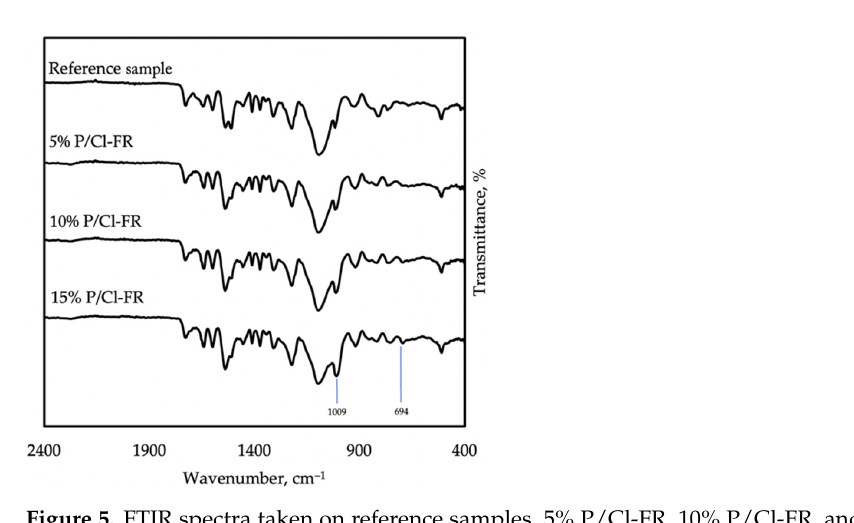
Figure 4. FTIR spectra taken on reference samples, 5% P-FR, 10% P-FR, and 15% P-FR, showing the influence of RDP.